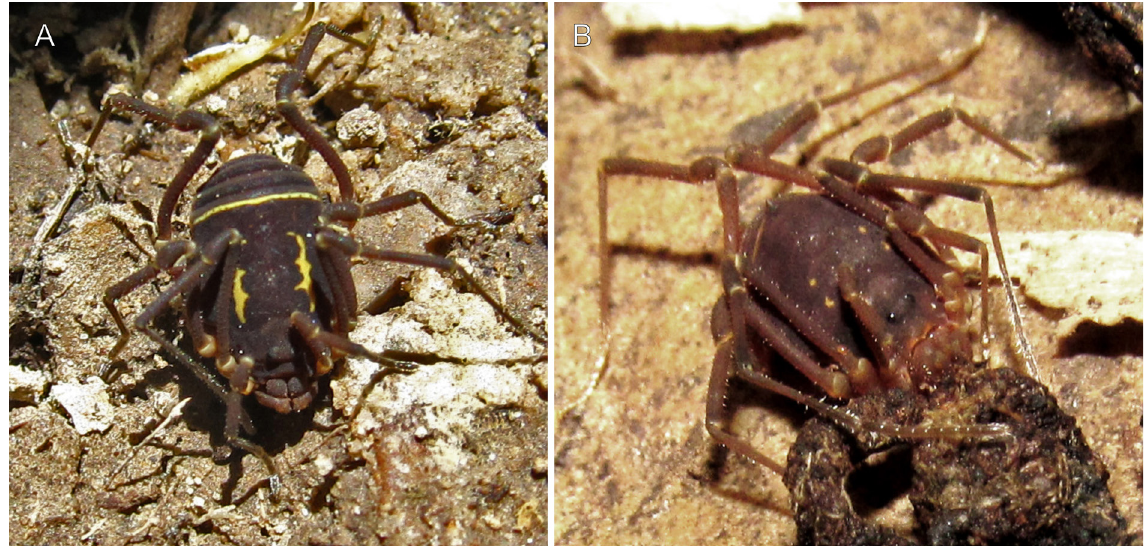
Fig. 31. Living specimens. A . Eulibitia scalaris (Sørensen in Henriksen, 1932) comb. nov.